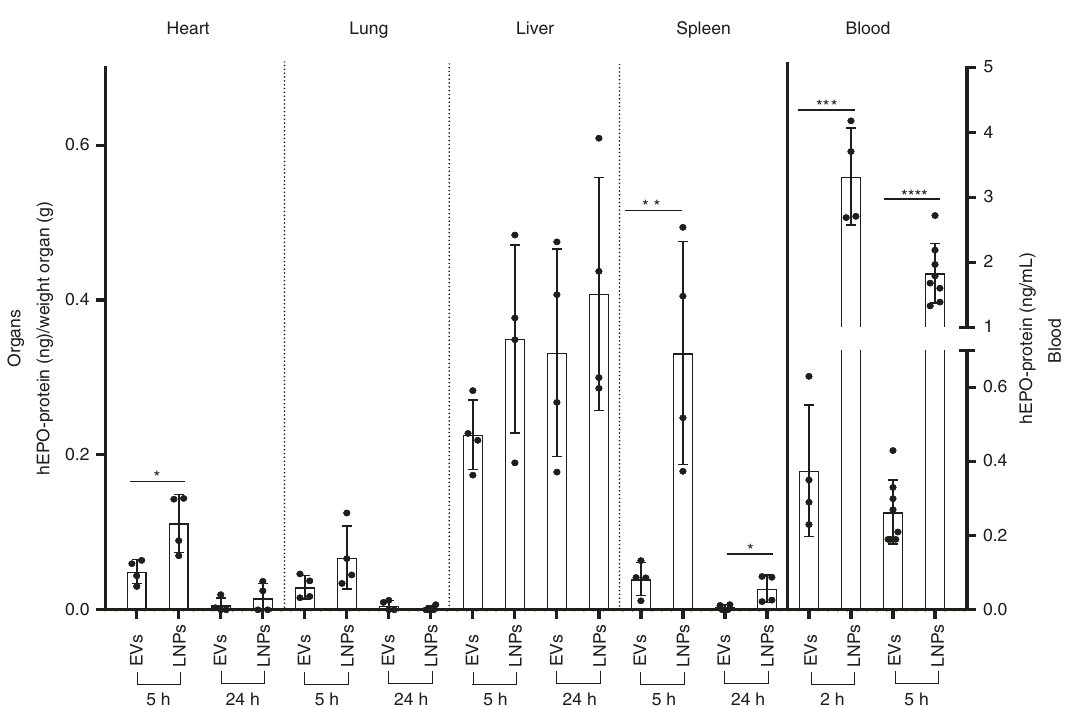
Fig. 5 Comparison of hEPO protein levels in murine blood and organs. The ability of mc3-EVs and MC3-LNPs to produce hEPO protein upon injection of equal doses of hEPO mRNA (1.5 µ g) into mice was compared. In most organs, the amount of hEPO protein was comparable between LNPs and EVs except for the spleen, which showed a signi fi cant difference in protein production followed by the heart (less signi fi cant difference). The most signi fi cant difference was observed in the plasma levels of hEPO protein, which were considerably higher for MC3-LNPs than for mc3-EVs. Data are presented as the mean (bars) and standard deviation (SD) n = 4 independent animals at each time point except for LNPs and EVs at 5 h for plasma analysis ( n = 8). EV and LNP groups were compared for each organ or plasma at each time point using the unpaired two-tailed Student ’ s t -test. * p < 0.05, ** p < 0.01, *** p < 0.001, and **** p < 0.0001. Source data are provided as a Source Data fi